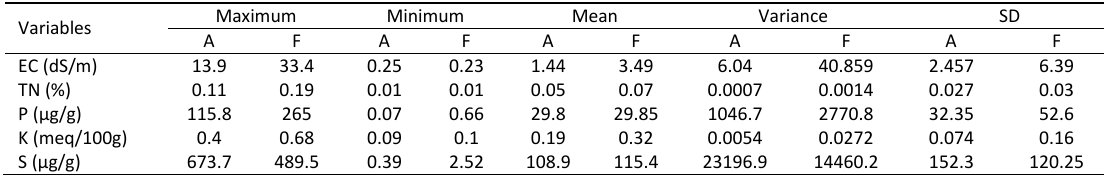
Table 1: Summary statistics for the soil variables (A=Agricultural Land; F= Fallow Land) Variables